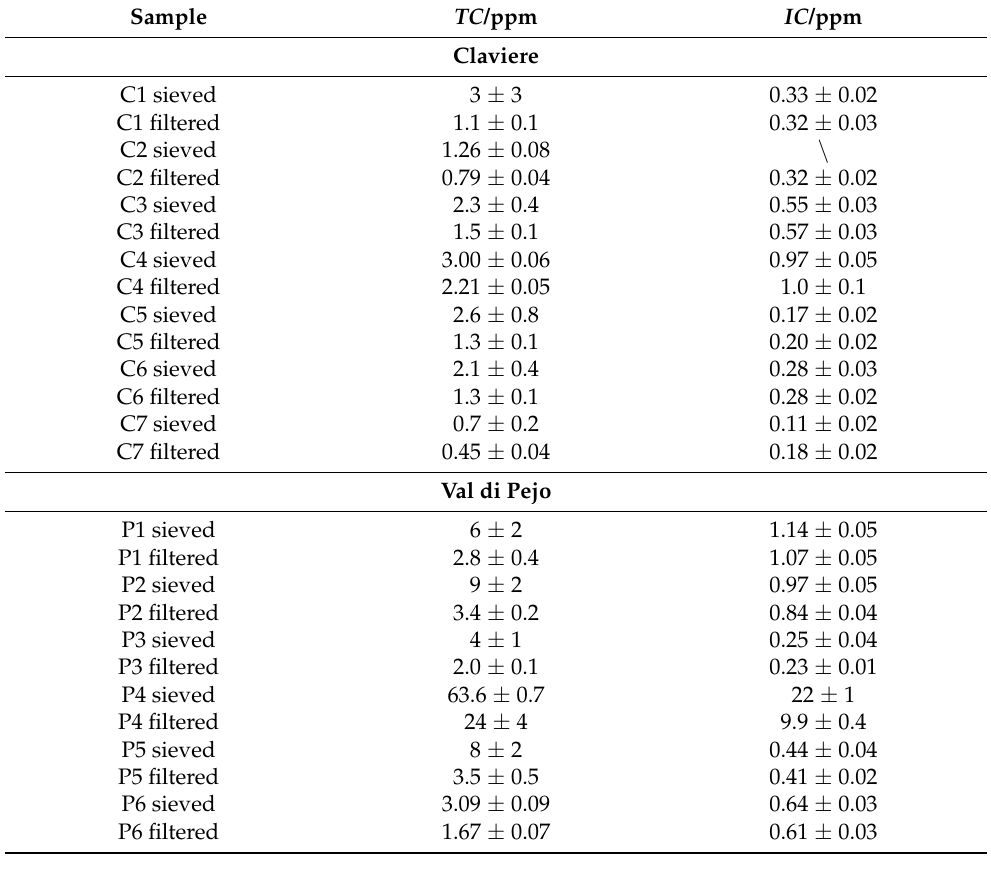
subtraction. Referring to Figure 4, the sieved sample is the ‘upper’ suspension while the filtered sample is the ‘lower’ solution.